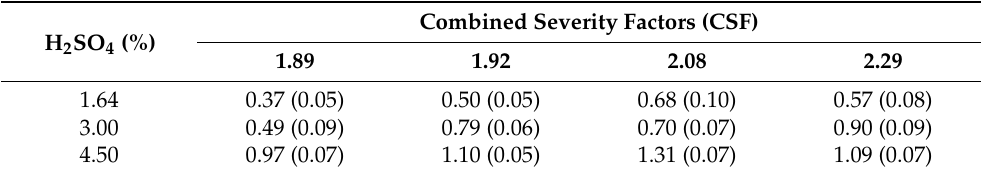
Table 3. Humin production during dehydration of xylose into furfural at various H 2 SO 4 concentrations (Unit: g).